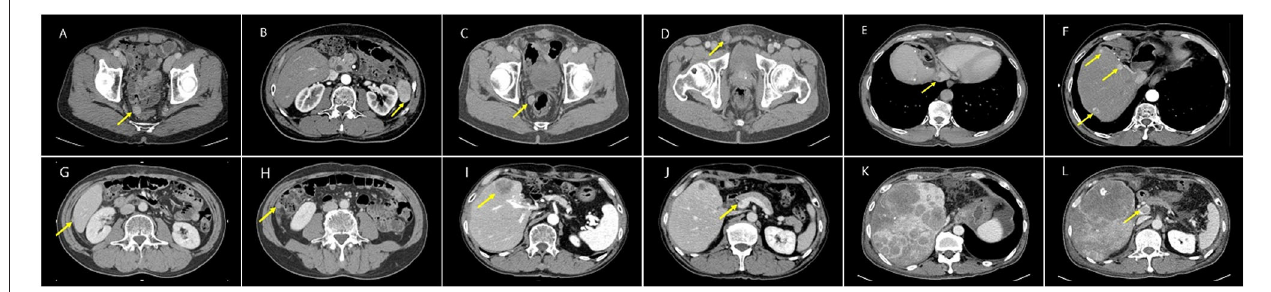
FIGURE 2 | Images of patients No. 2 (A–F) and No. 5 (G–L) with HCC recurrence. (A,B) Rectal serosal, subsplenic lesion, (C,D) rectal serosal, right inguinal lesion, (E,F) IVC tumor thrombus, intrahepatic multiple HCC, (G,H) perihepatic, subhepatic lesion, (I,J) intrahepatic HCC recur, portal vein tumor thrombus, and (K,L) aggravation of intrahepatic lesions and portal vein tumor